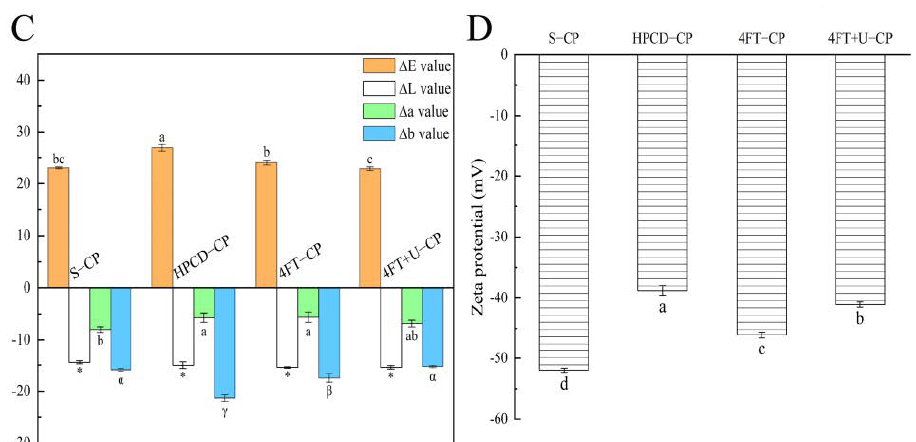
Figure 1. Absorption spectra ( A ), CP purities ( B ), color analysis ( C ), and zeta potential ( D ) of CPs obtained by different extraction methods. Different lowercase letters or single asterisks indicate significant differences ( p < 0.05).